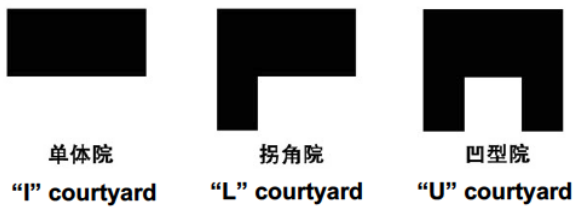
Figure 6. The Courtyard Organization Mode